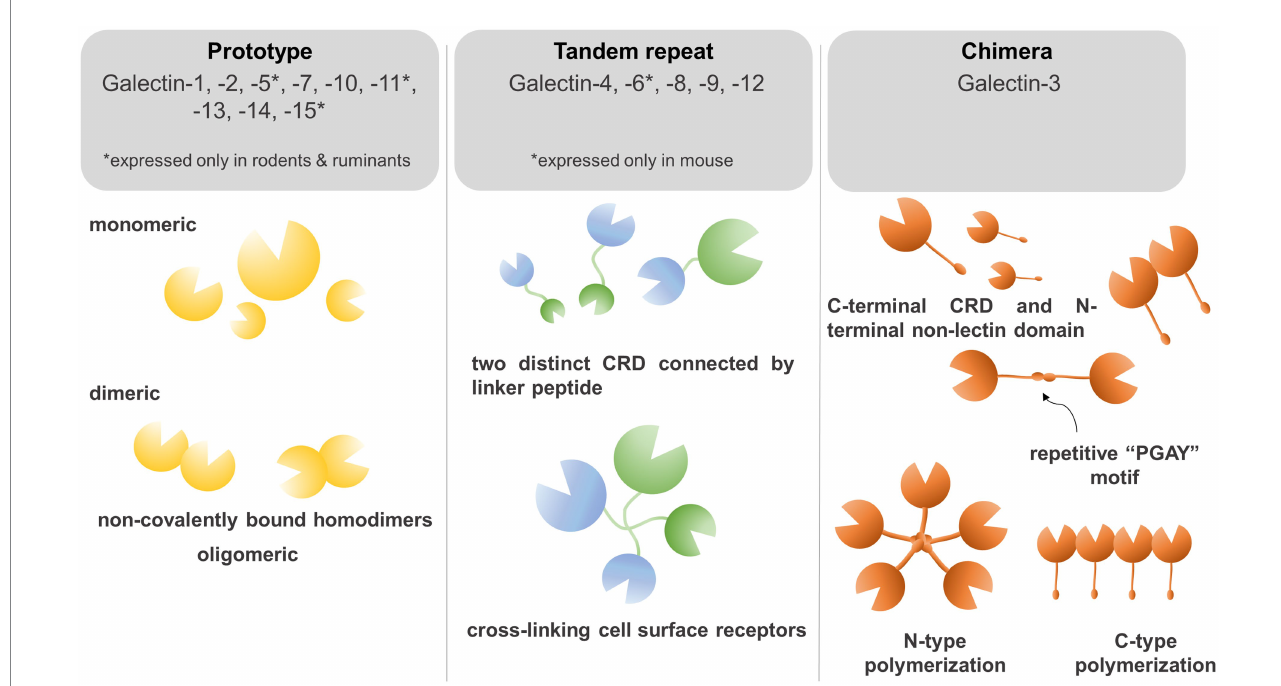
FIGURE 1 Galectins bind to β -galactose-containing glycoconjugates through a carbohydrate recognition domain (CRD). Based on their CRD domain structures, mammalian galectins were classified into proto, chimera, and tandem-repeat isoforms. Prototype galectins (Galectin − 1, − 2, − 5, − 7, − 10, − 11, − 13, − 14, and − 15) contain an individual CRD domain per polypeptide and form non-covalently linked homodimers. Tandem-repeat galectins (Galectin − 4, − 6, − 8, − 9, and − 12) are composed of two CRDs connected by an unstructured linker peptide that allows for crosslinking of galectins on the cell surface. The chimera- type galectin-3 consists of one CRD domain on the C-terminus and a non-lectin N-terminus which represents two phosphorylation sites crucial for subcellular trans-localization. The N-terminus repetitive “PGAY” motif allows for N-type polymerization to pentamers, whereas multiple CRD domains can form β -sandwich